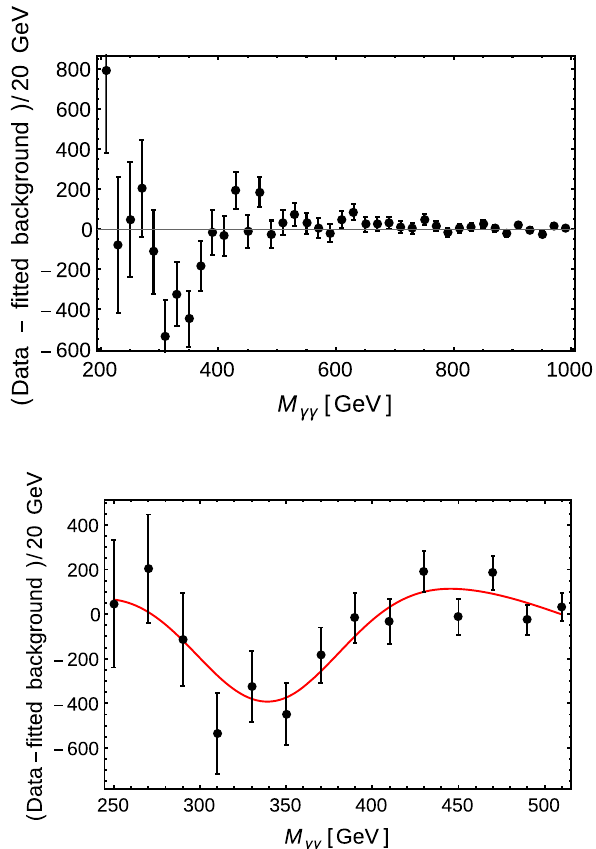
Fig. 5 The top plot shows the difference between the binned events and their smooth fit by the ATLAS fitting function [Eq. (5)] obtained for the combined gg → γγ + qX → γγ processes. The bottom plot shows the difference modeled with the function defined in Eq. (7) in the range 250 ≤ M γγ ≤ 510 GeV